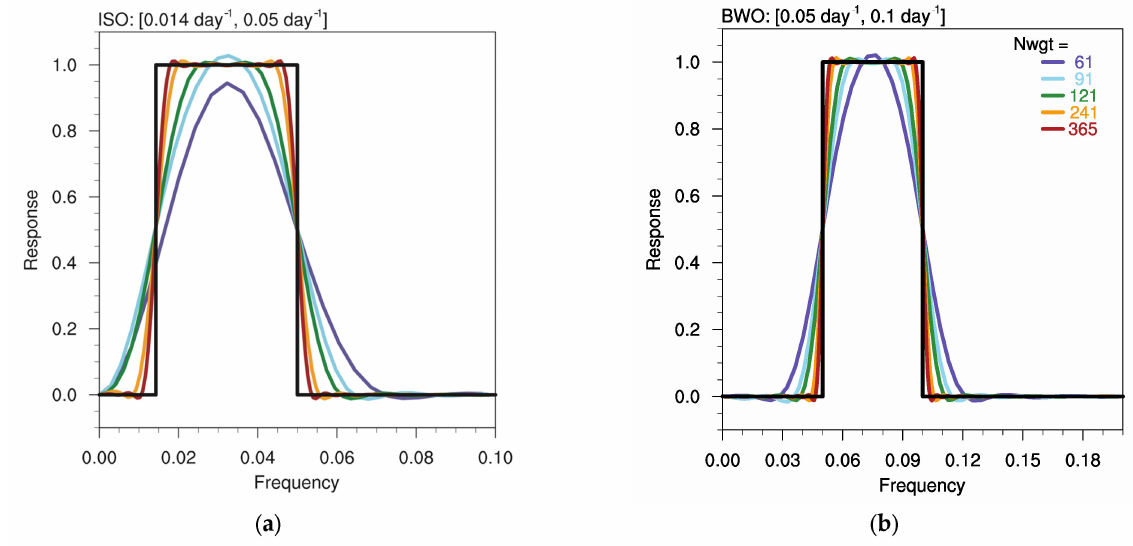
Figure 1. Response function of Lanczos bandpass filter. The cut-in and cut-out frequencies are equal to 0.014 and 0.05 day − 1 for ( a ) ISO oscillation and 0.05 and 0.1 day − 1 for ( b ) BWO oscillation. Total five filter weights are compared: 61, 91, 121, 241 and 365. Black curves give the ideal band-pass response function with the cut-off